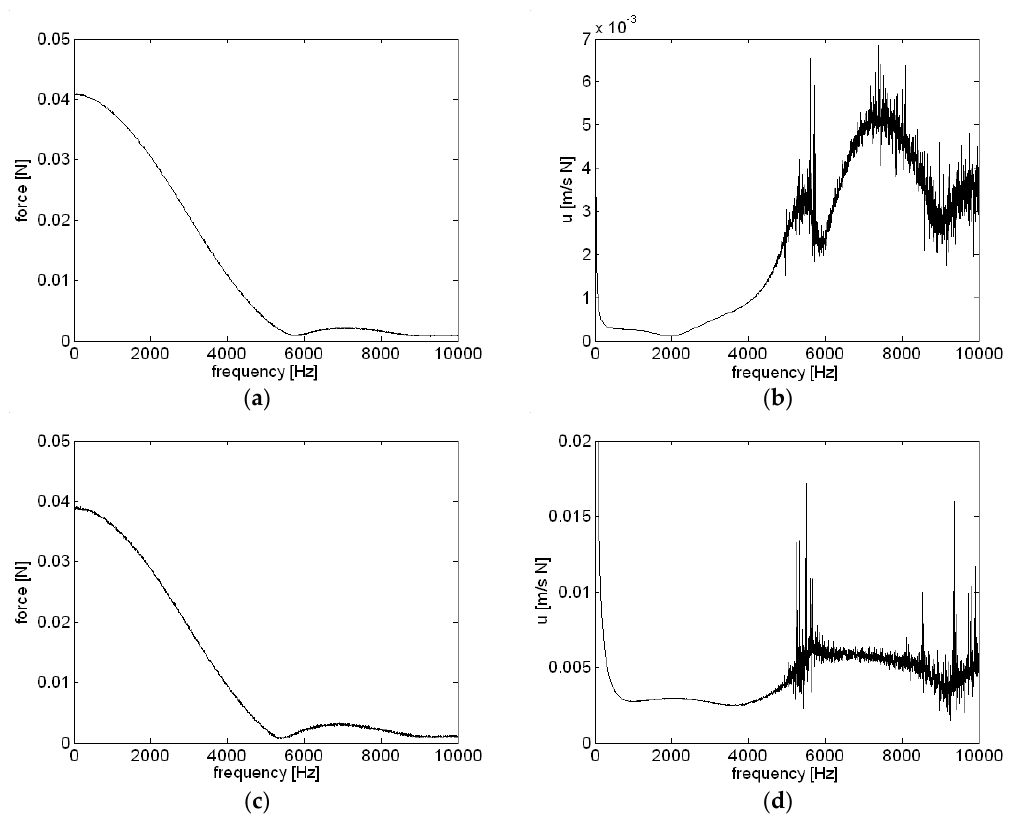
Figure 5. Response of the motor housing at different locations due to external excitation from a hammer: ( a ) 90°, force; ( b ) 90°, particle velocity; ( c ) 180°, force; ( d ) 180°, particle velocity.